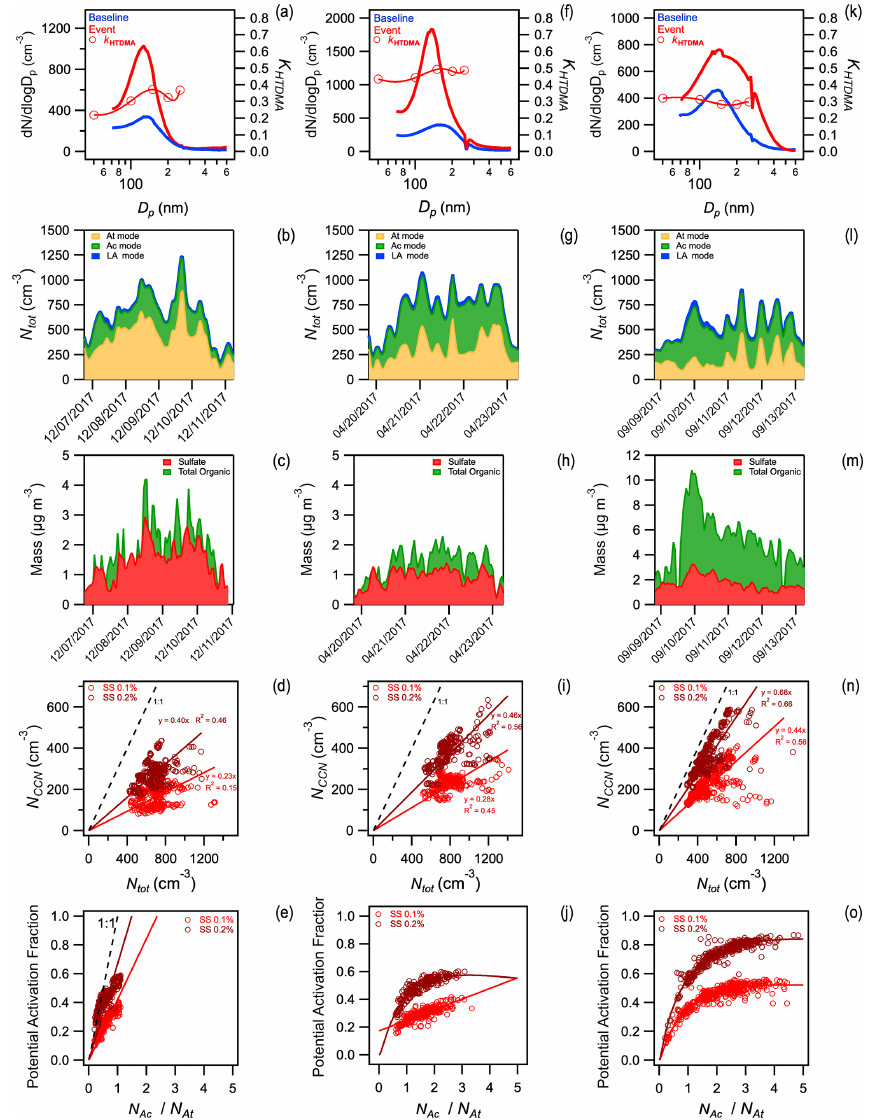
Figure 7. Case study of December 2017 (leftmost), April 2017 (center), and September 2017 (rightmost) events. Submicron particle size distribution under baseline conditions (blue) and during the events (red) and κ HTDMA (open circles) during the events (a, f, k) ; Aitken, accumulation, and large accumulation mode contributions to (b, g, l) ; non-refractory sulfate and organic aerosols (c, h, m) ; scatter plot of N CCN versus N tot during the event (red circle) and fitting lines for the events at SS 0.1% (red) and at SS 0.2% (dark red) (d, i, n) ; and plot of potential activation ratio versus N Ac /N At or the events at SS 0.1% (red) and at SS 0.2% (dark red) (e, j, o) .